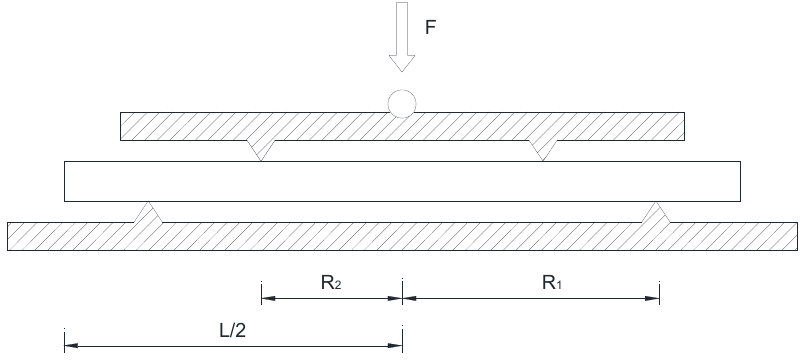
Fig. 4 CDR test configuration with no overpressure (L = 100 mm, R 1 = 45 mm and R 2 = 9 mm).